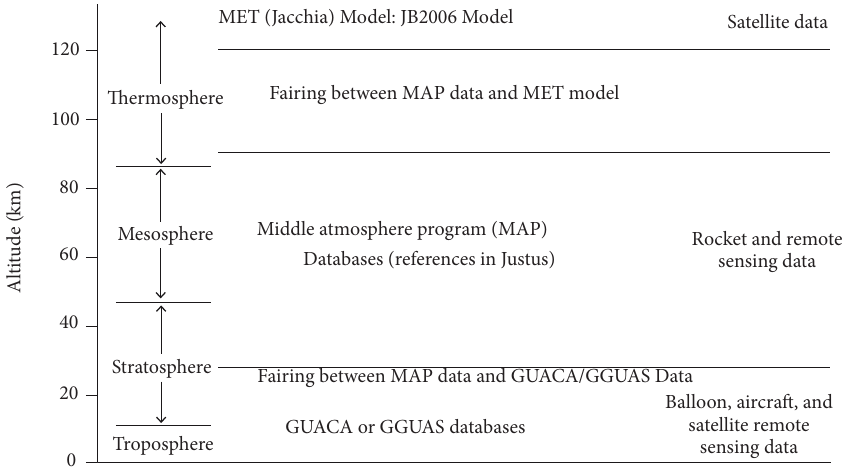
Figure 3. Schematic summary of the atmospheric regions versus altitude in the GRAM-07 program, and sources for the models/data on which the mean monthly GRAM-07 values are based (Johnson,